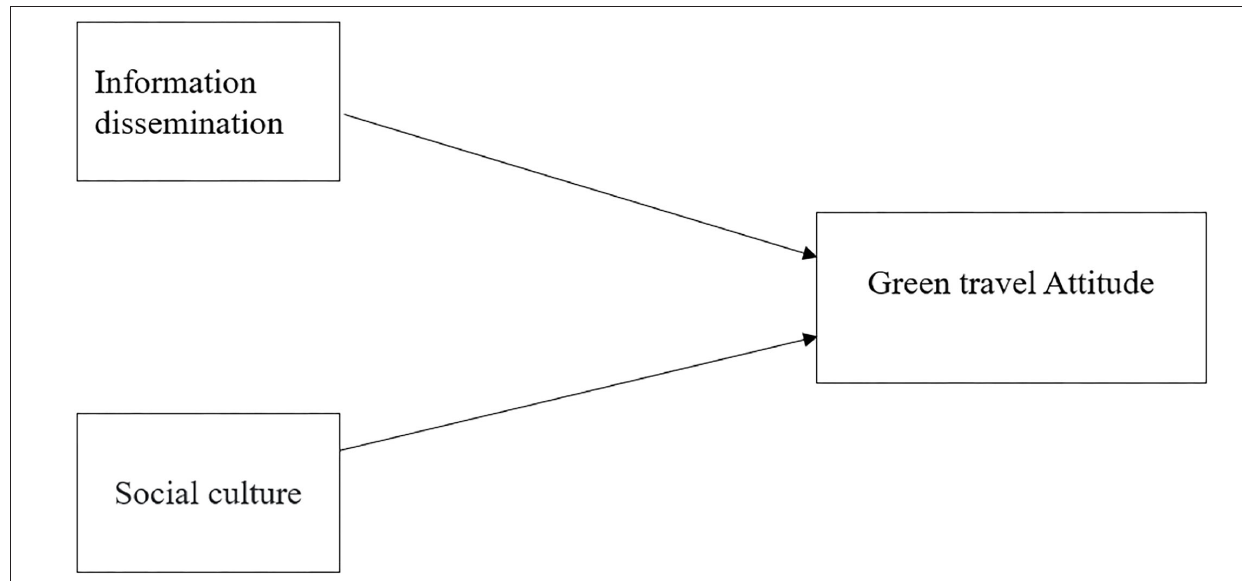
FIGURE 1 | Influence of social propaganda policies on public attitude toward green travel.